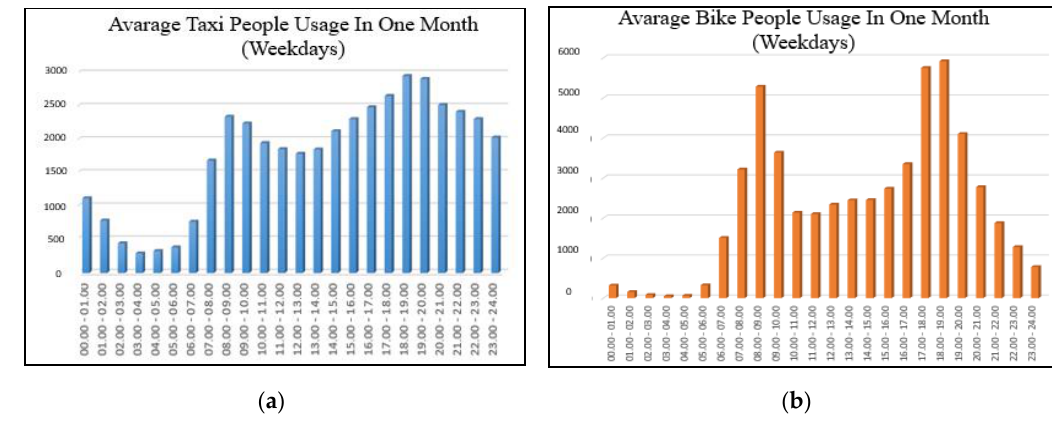
Figure 4. Average usage on weekdays for one month: ( a ) bike; ( b ) taxi.